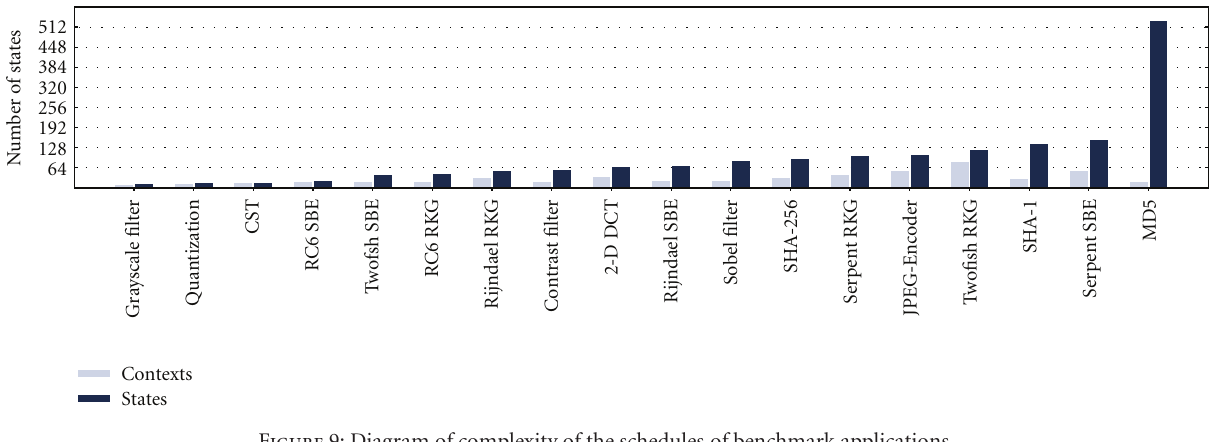
Figure 9: Diagram of complexity of the schedules of benchmark applications.